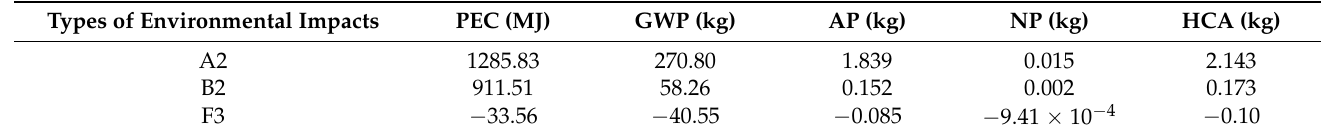
Table 7. Environmental-pollution impact of a 1 m 3